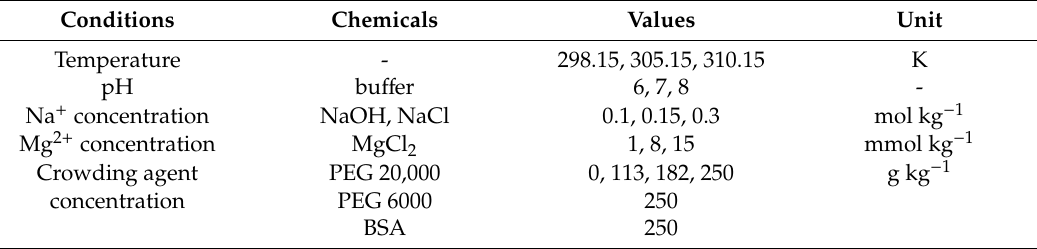
Table 3. Cytosolic conditions varied by the